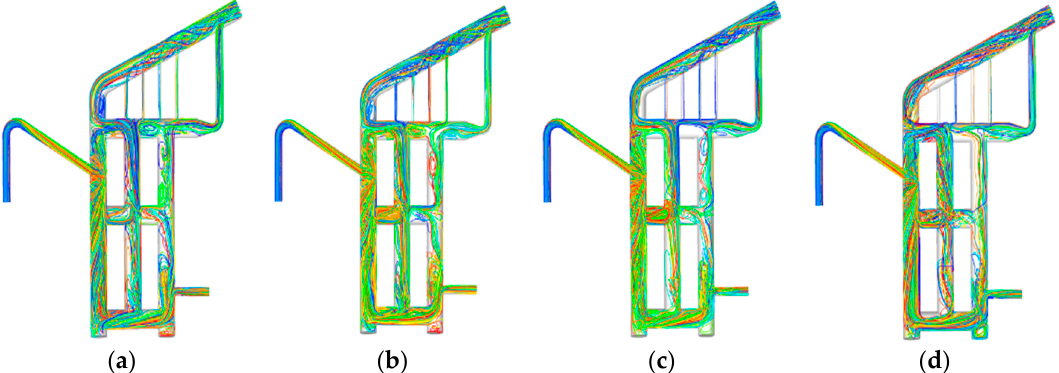
Figure 8. Effect of the gas–oil ratio on the gas–liquid separation flow field characteristics. ( a ) 100 m 3 /t; ( b ) 160 m 3 /t; ( c ) 220 m 3 /t; ( d ) 280 m 3 /t.